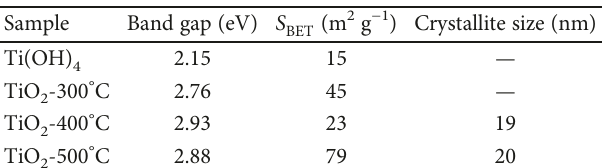
Table 1: Band gap energy, speci fi c surface area, and crystallite size of the materials.